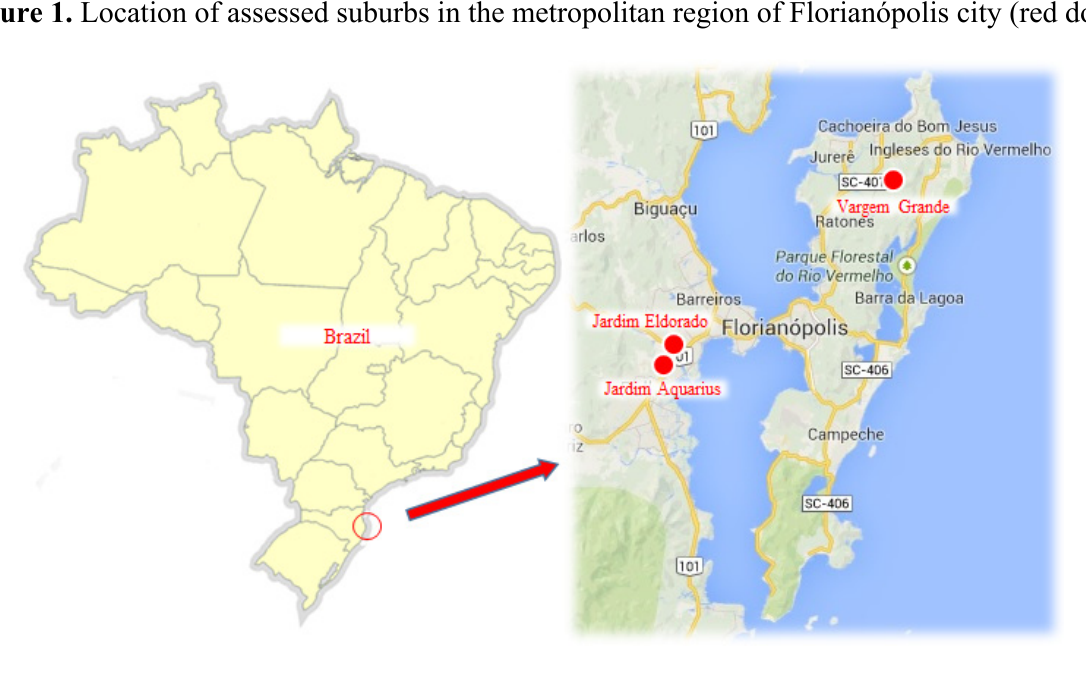
Figure 1. Location of assessed suburbs in the metropolitan region of Florianópolis city (red